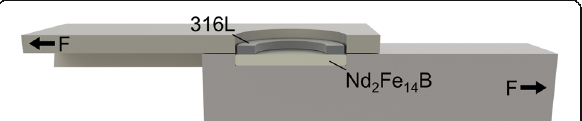
Fig. 5 Insert for shear testing the ultrasonically welded joints in a tensile testing